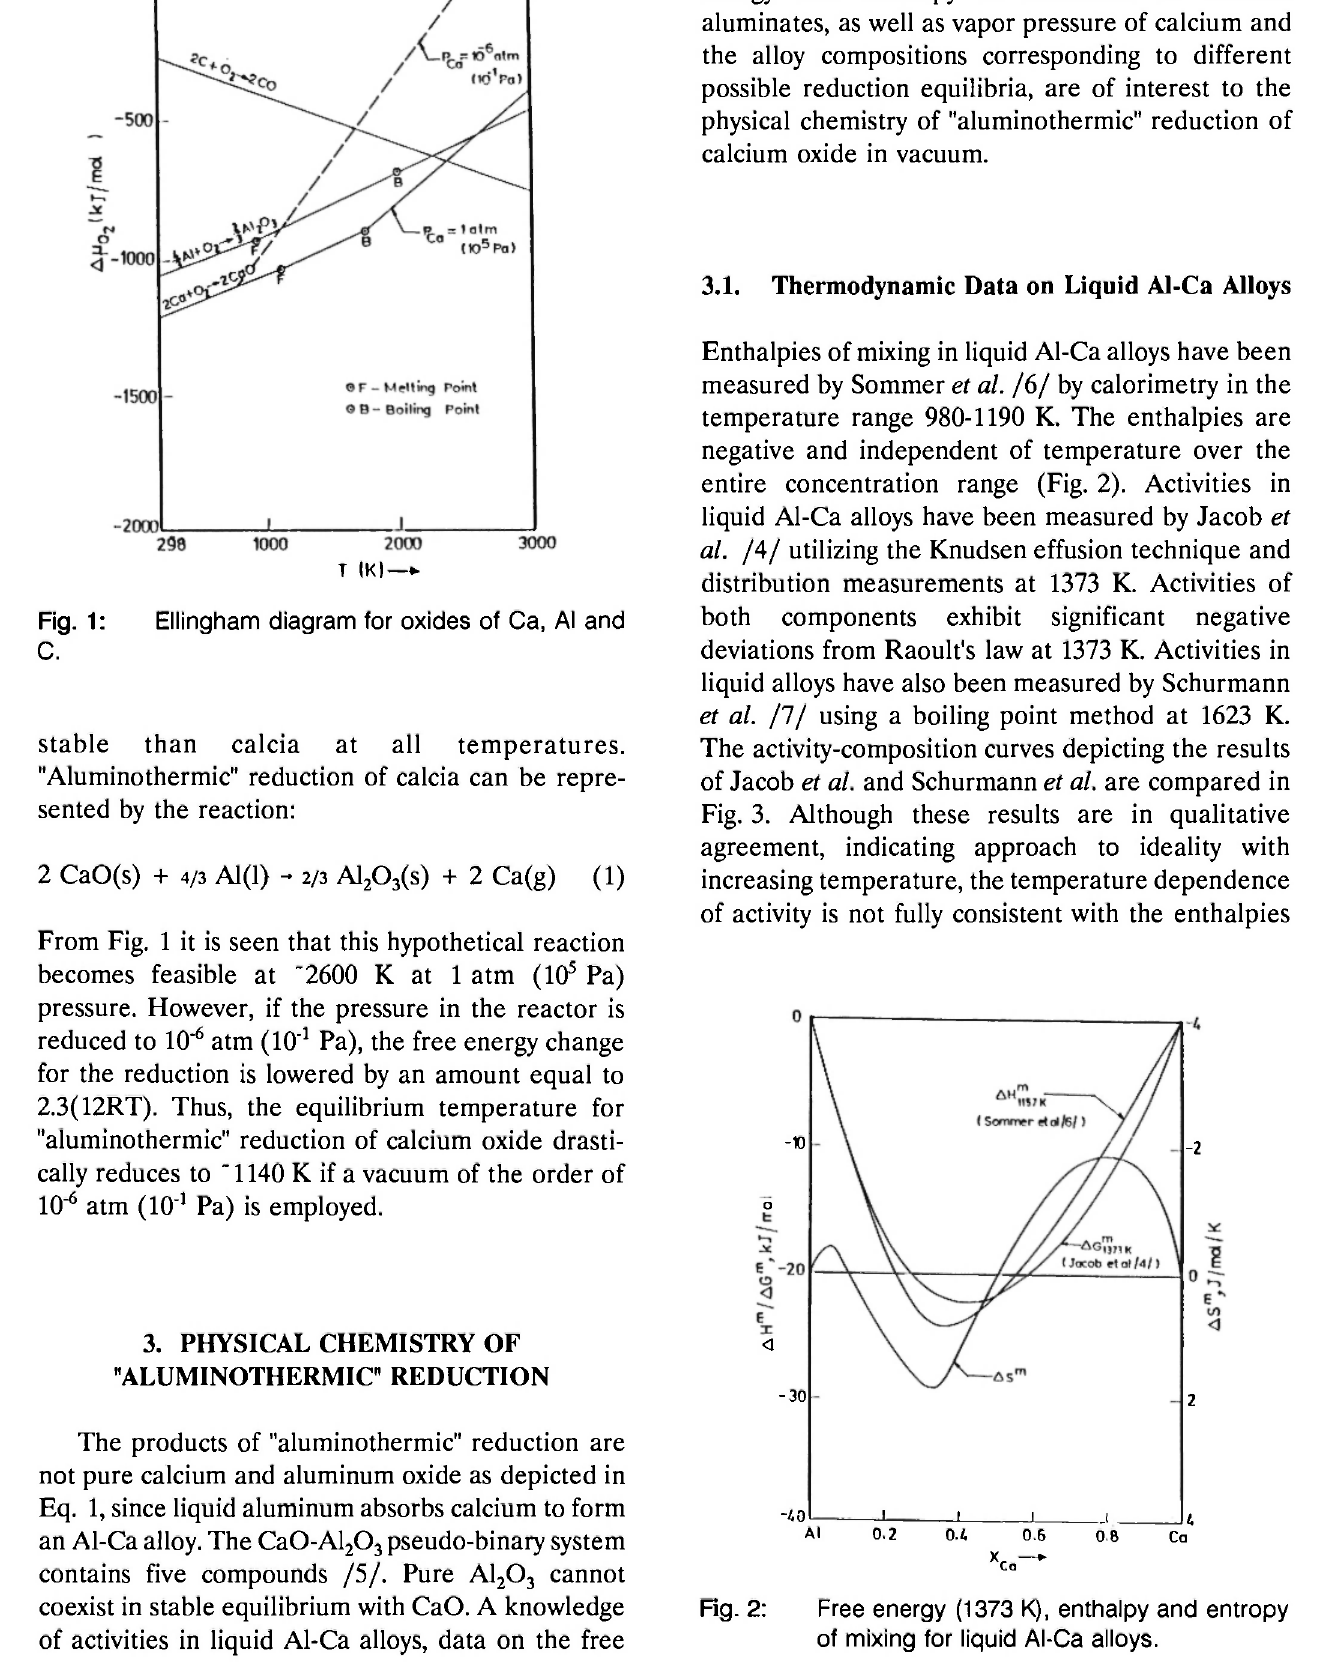
Free energy (1373 Κ), enthalpy and entropy of mixing for liquid Al-Ca